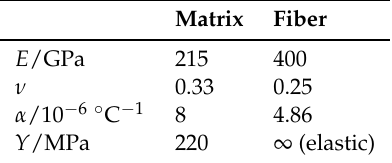
Table 1. Material and thermal properties for fiber and matrix.